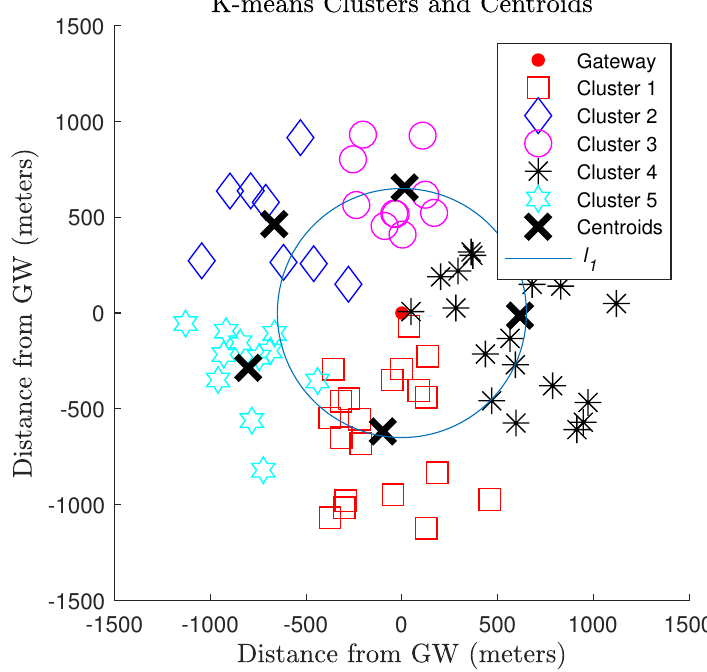
Figure 3. 5th iteration with Fibonacci series. Nodes outside l 1 use SF8, those inside use SF7.